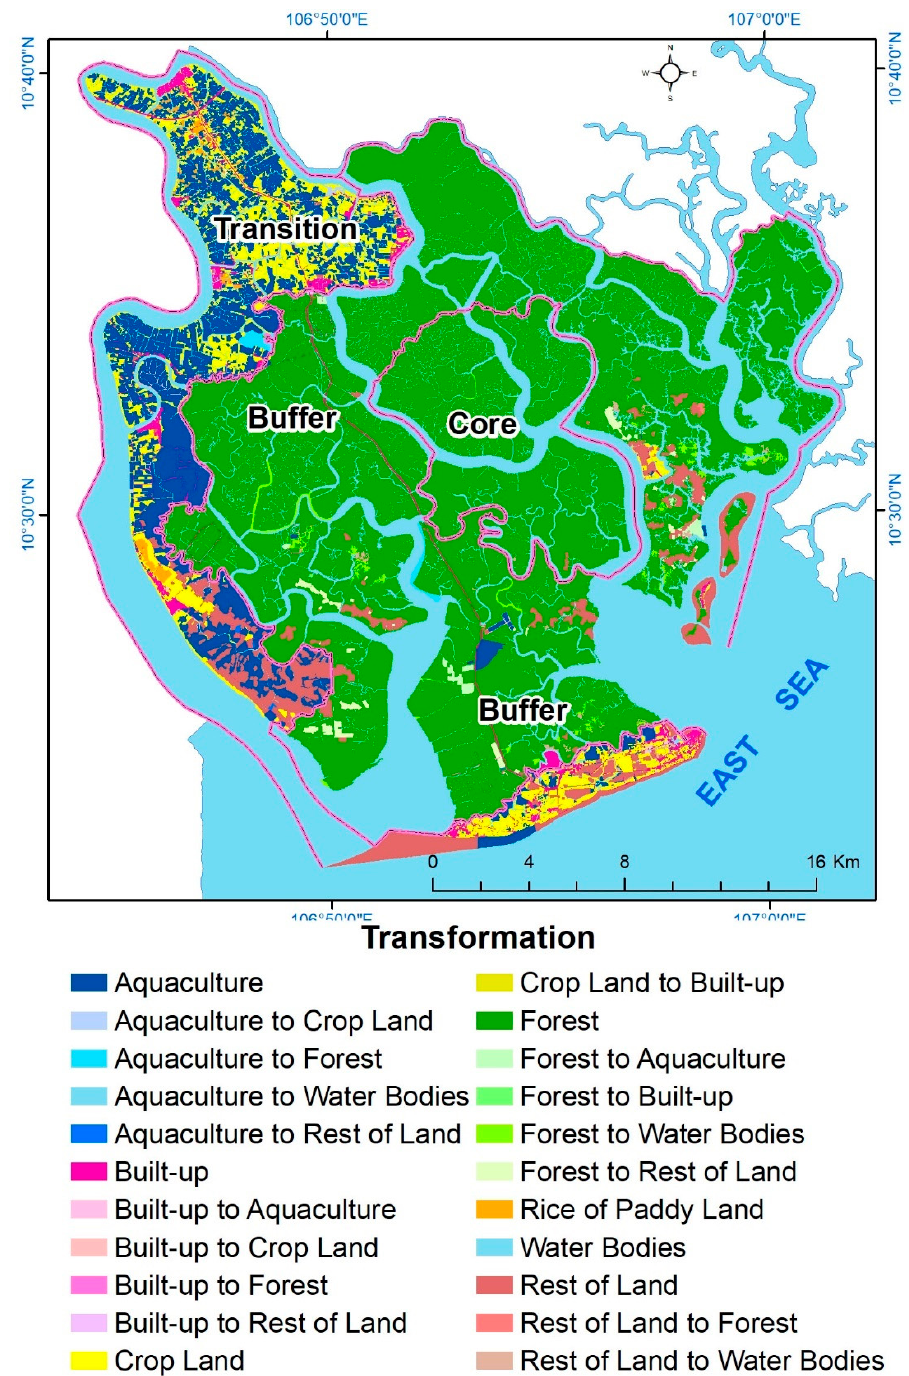
/ land cover change in the study area between 2015 and Figure 6. The land use/land cover change in the study area between 2015 and 2019. Figure 6. The land use